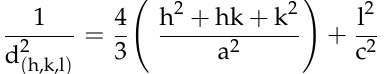
under the first-order reflection (n = 1) on the (100) and (002) planes. The obtained results indicate an increase in the lattice parameters of deposited Zn 1 − x Ni x O films for a nickel content of x = 0.02 and their decrease with a further increase in